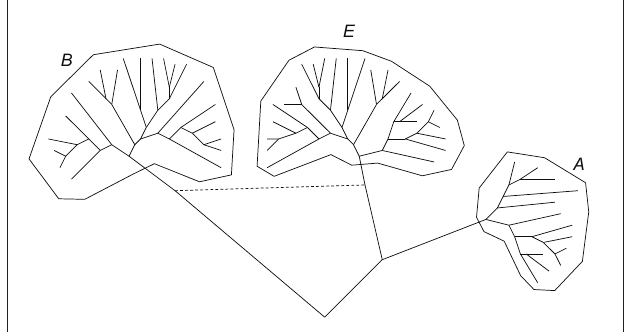
FIGURE 1 | The three-domain tree of life: a generalized schematic, A, Archaea, B, bacteria, E,